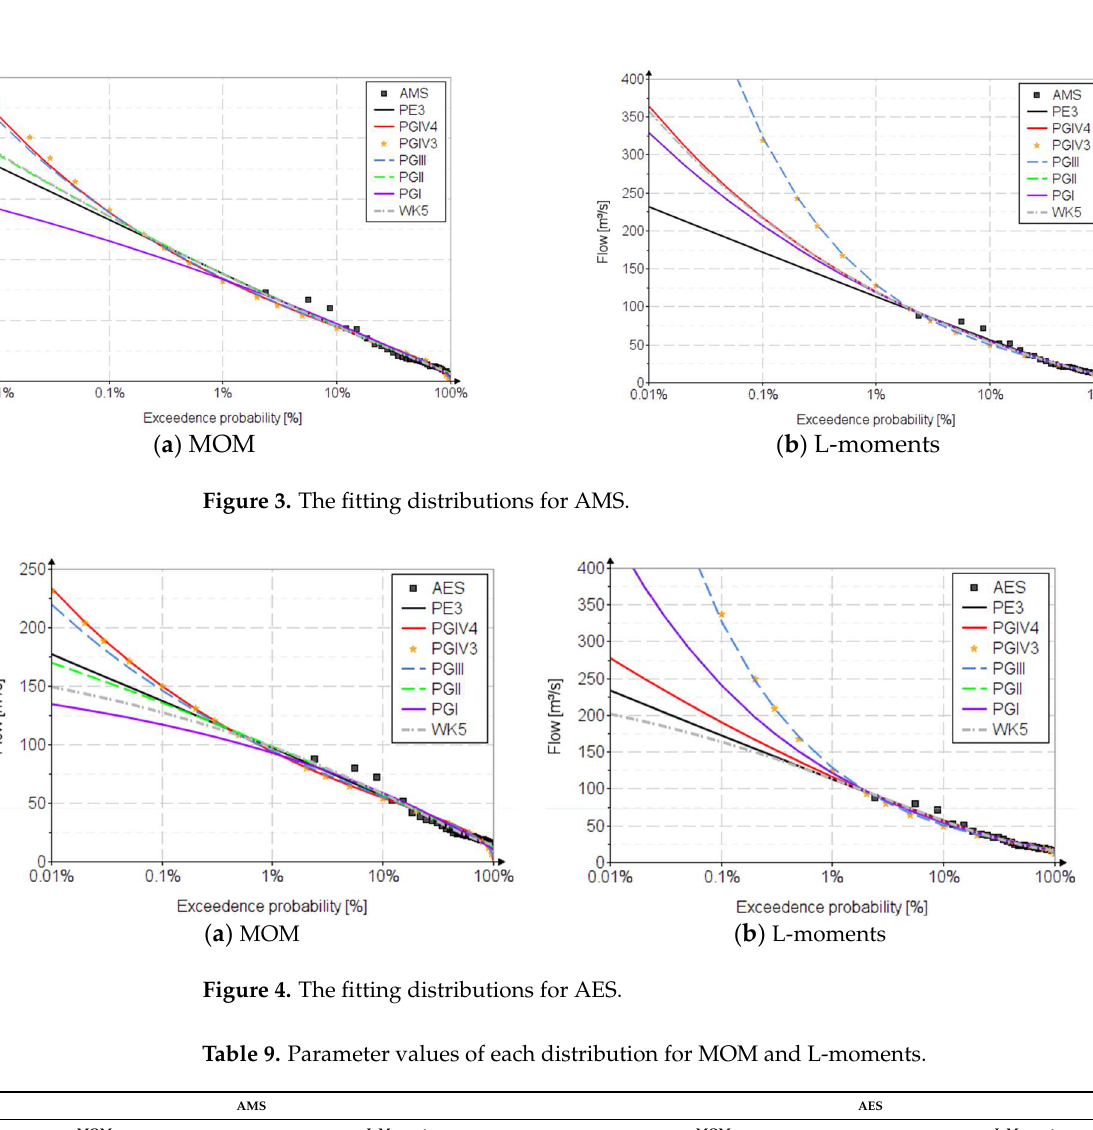
Table 9. Parameter values of each distribution for MOM and L-moments.